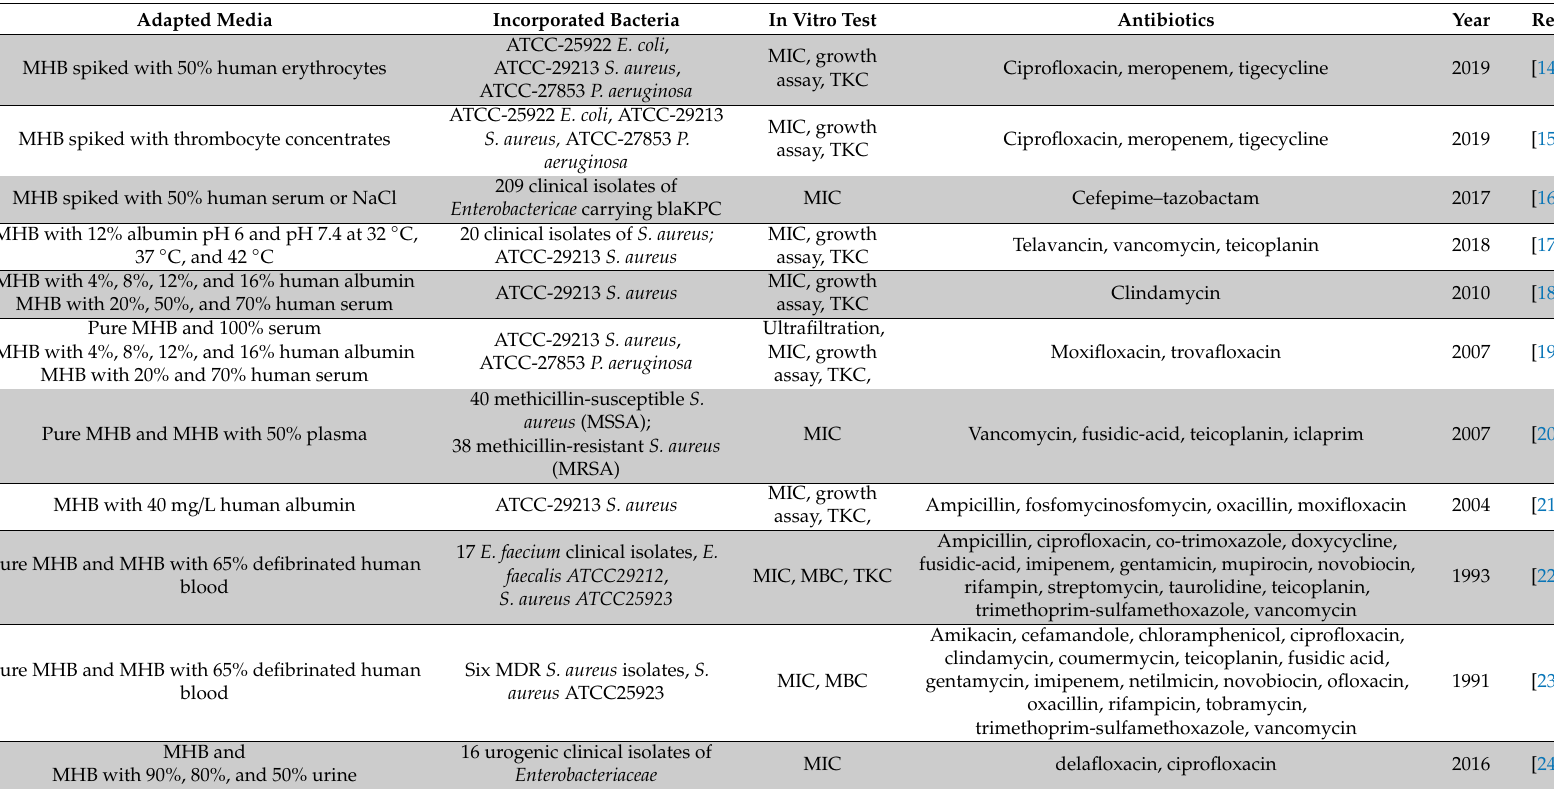
Table 2. Adapted